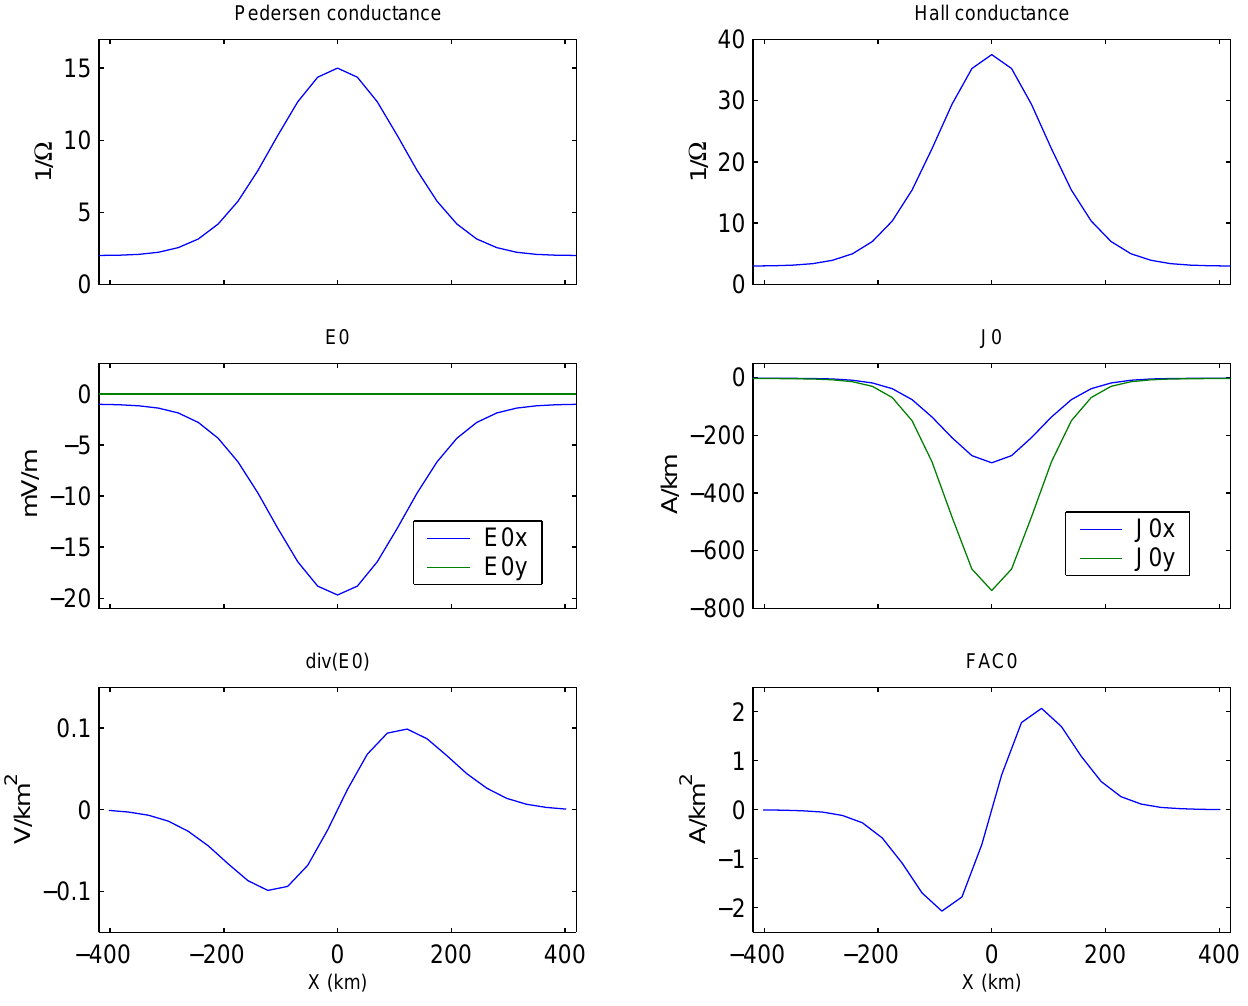
Fig. 2. The electrojet model. Electrojet is uniform in the y-direction. This figure shows the profiles of Pedersen and Hall conductances, electric field E 0 , ionospheric current density J 0 , divergence of the electric field and FAC in the x-direction.